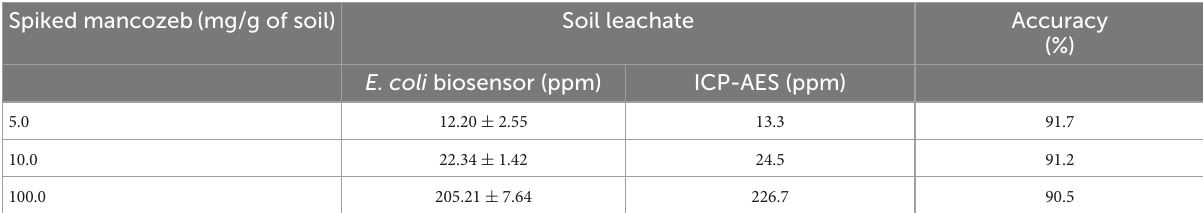
TABLE 4 The amount of Mn(II) originated from mancozeb amended soil samples determined by Escherichia coli -cell based biosensor and inductively coupled plasma–atomic emission spectroscopy (ICP–AES) analysis. Spiked mancozeb (mg/g of soil) Soil